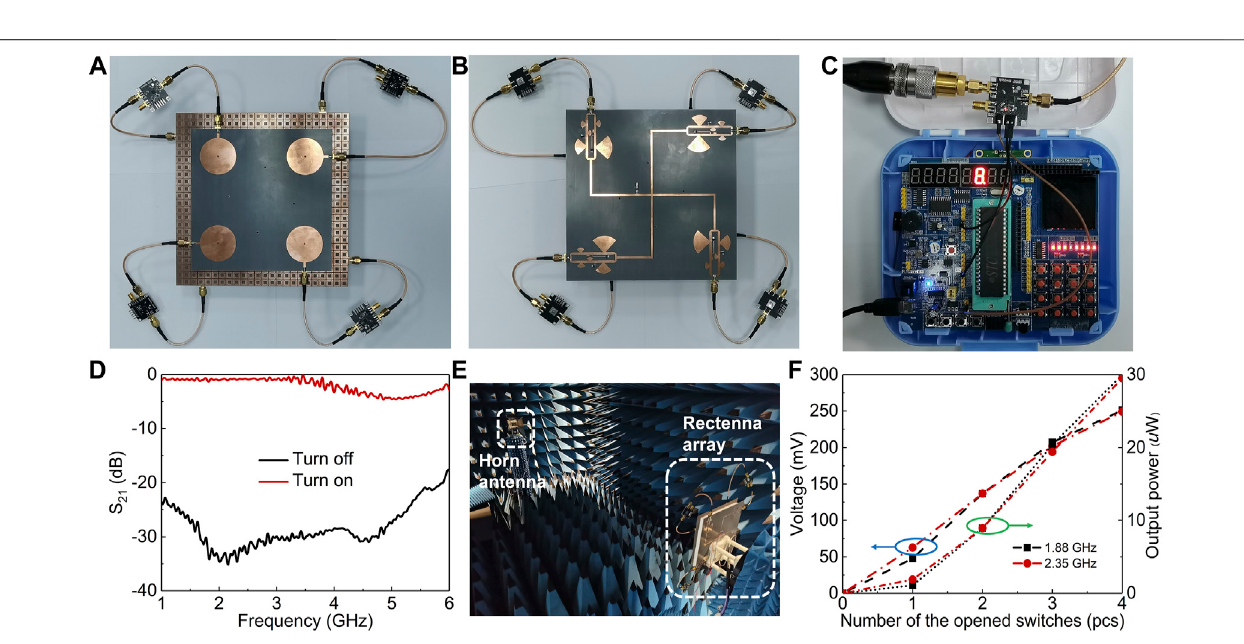
FIGURE6|(A,B) Photographoftherectennaarray. (C) Thephotograph ofthesingle chipmicrocomputerandRF switch. (D) Themeasured S21oftheswitch. (E) Measurement setup inside an anechoic chamber. (F) Measured voltage and out power of the rectenna array versus the number of the opened